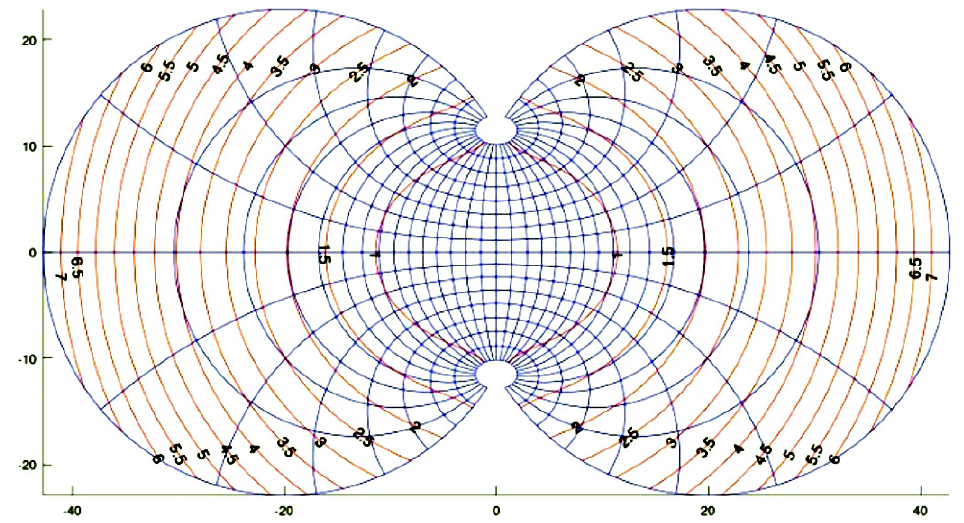
Fig. 12. The cartographic grid and the distribution of distortions in the Lagrange